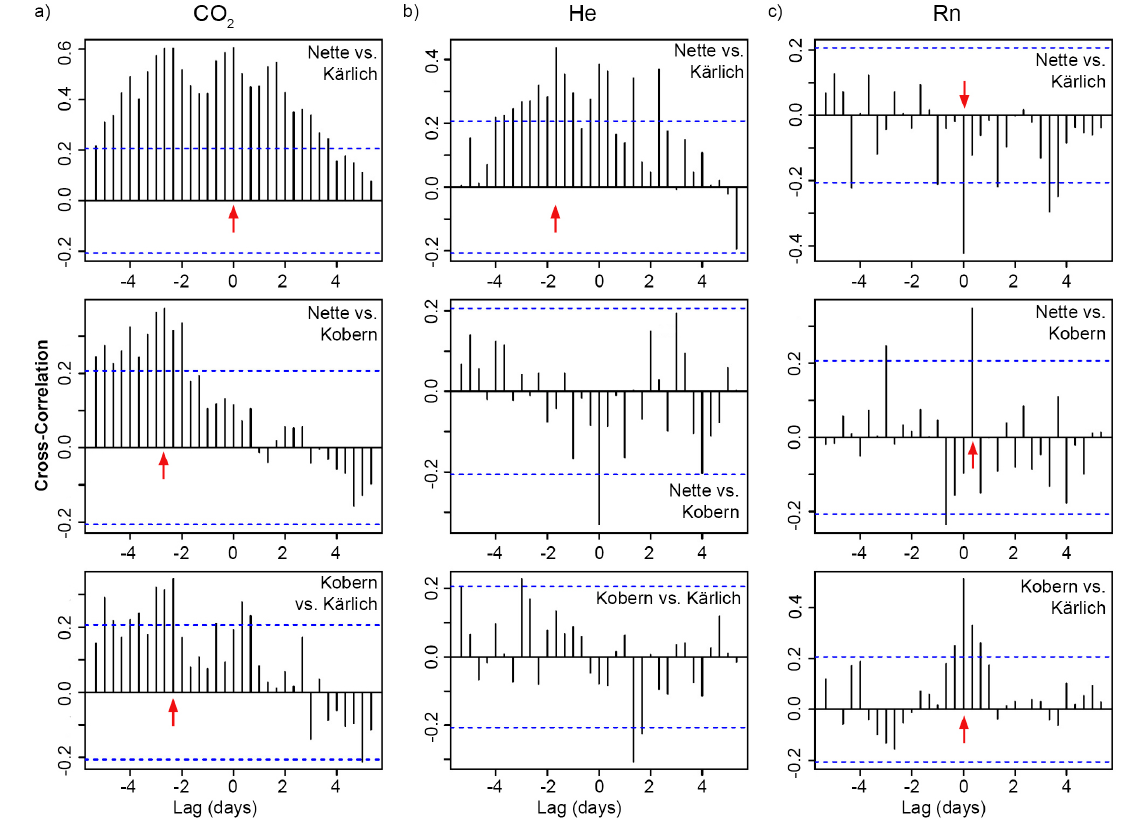
Figure 6. The time-series of ( a ) CO 2 , ( b ) He, and ( c ) Rn (8-hourly samples; median smoothed) between all springs for the 4-W campaign. Red arrows indicate highlighted correlations. Blue dashed lines indicate 5% significance levels (values outside the blue dashed lines are statistically significant at P ≤ α = 0.05).